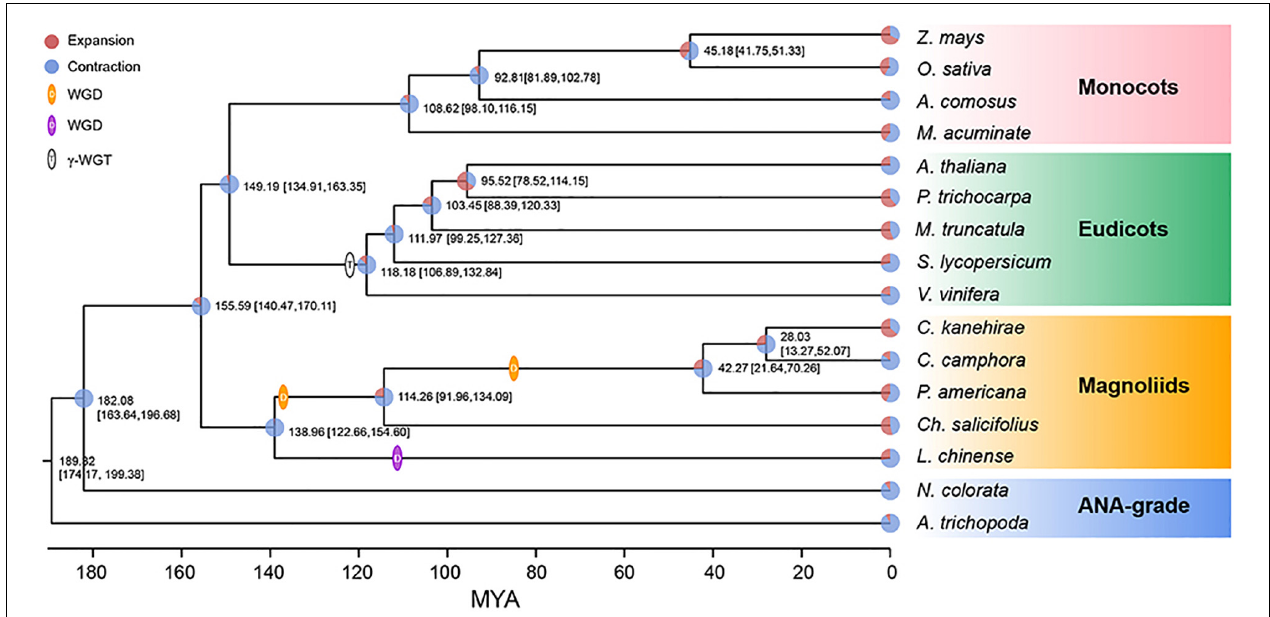
FIGURE 2 | Phylogenetic analyses. The phylogenetic tree was constructed based on 172 single-copy orthologous genes of 16 species using two ANA-grade species as outgroups; node age and 95% confidence intervals are labeled. Pie charts show the proportions of gene families that underwent expansion or contraction. Predicted whole-genome duplication (WGD) events were only indicated for Laurales and